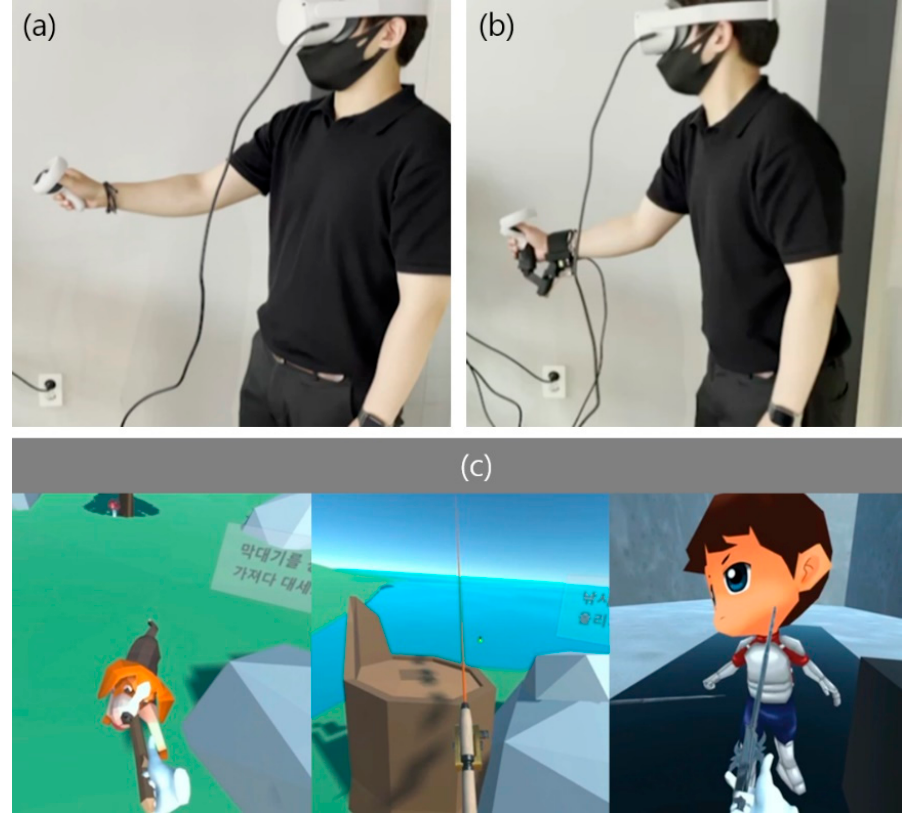
Figure 7. User evaluation experiment ( a ) using only the controller and ( b ) using the haptic device and the controller together; ( c ) examples of screens seen by the participants during the experiment.